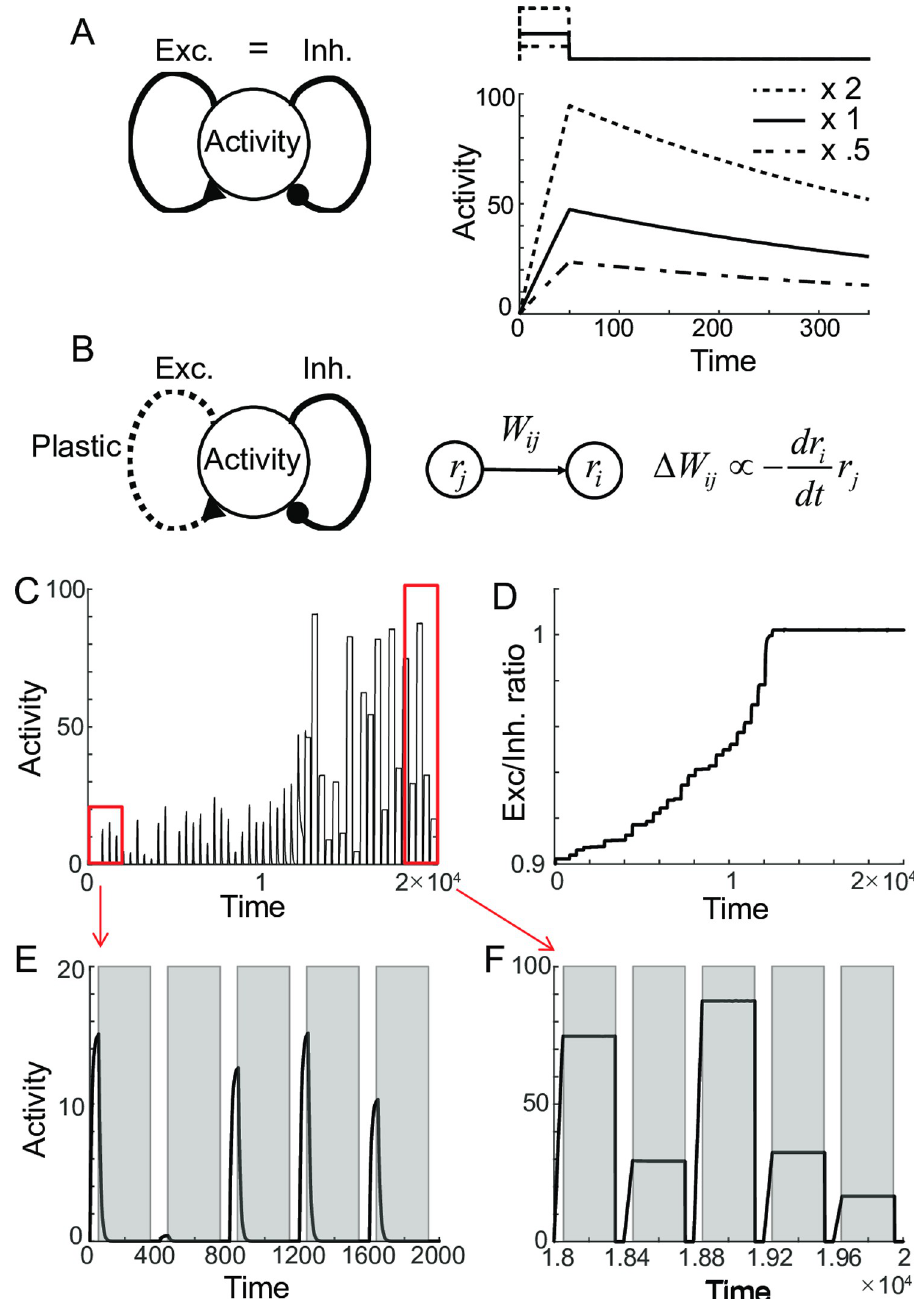
Fig 1. Recovery of rate-coded persistent activity through differential plasticity. A: Maintenance of persistent activity through negative-derivative feedback. With balanced excitation and inhibition as well as slower excitation, the network can maintain persistent activity at different rates. The top panel illustrates the schematic of a pulse-like stimulus. The dotted and dash-dotted curves in both top and bottom panels represent stimulus and activity with double and half the input strengths compared to the solid one. B: Schematics of differential plasticity in the excitatory feedback. C-D: Recovery of persistent activity (C) and E-I balance under differential plasticity (D) after perturbations in connectivity strengths. E-F: Activities with 10% perturbation (E) and after the recovery (F). The time axis is in the unit of intrinsic time constant τ , and one trial is composed of the stimulus presentation, delay period, and an inter-trial interval. Shaded areas represent the delay period during which the plasticity